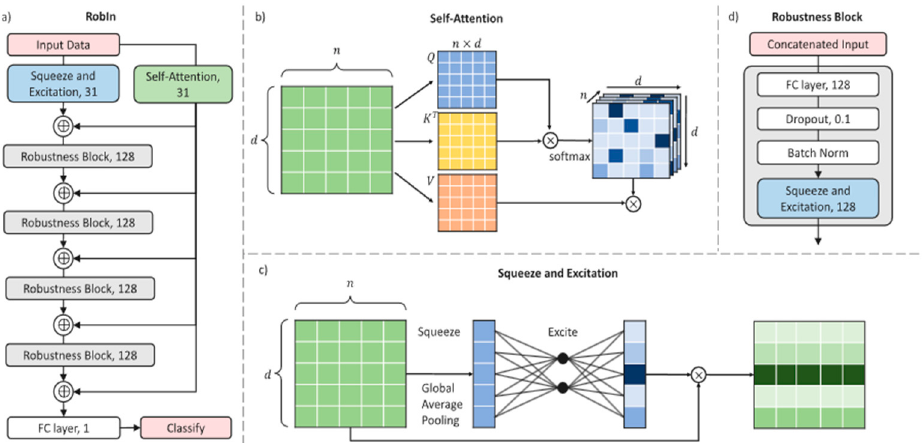
Figure 4. Structure of Robin architecture implemented by Organisciak et al. [33]. (a) An overview of the entire network with output dimensions of each layer represented. Input data goes down the robustness stream and the interpretability stream; (b) self-attention mechanism: the input represen- tation is converted into a key, query and value matrix, the cosine distance between each query and each key is found via a matrix multiplication with a higher activation signalling higher alignment between query and key; (c) squeeze and excitation: each attribute 𝑖 = 1, ... , 𝑑 is squeezed down to a representative number, a miniature neural network excites the squeezed information to evaluate how important each attribute is, then the initial data is multiplied by the importance scores; (d) the robustness block we propose in this